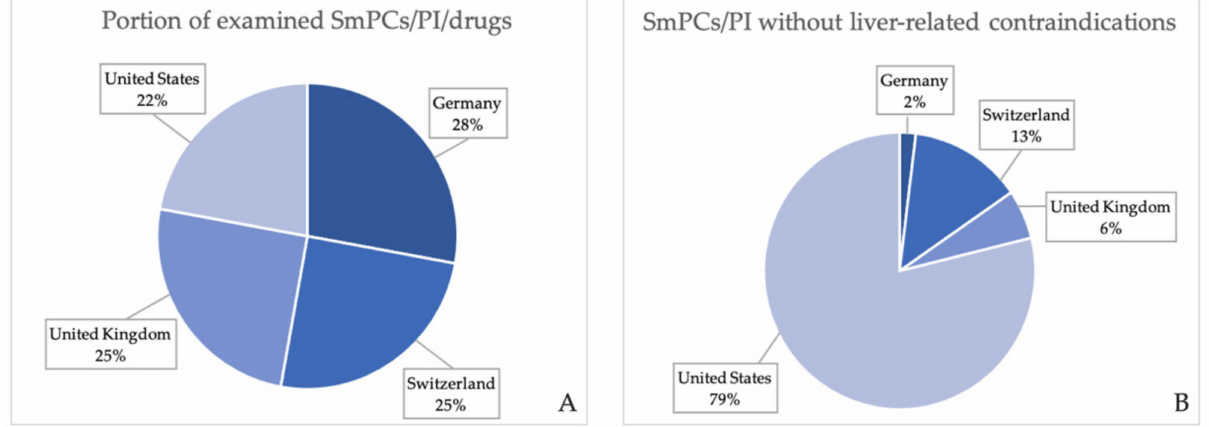
Figure 4. ( A ) Each drug market’s portion of the total amount of examined SmPCs/PI. ( B ) Each drug market’s portion of all examined SmPCs/PI without liver-related